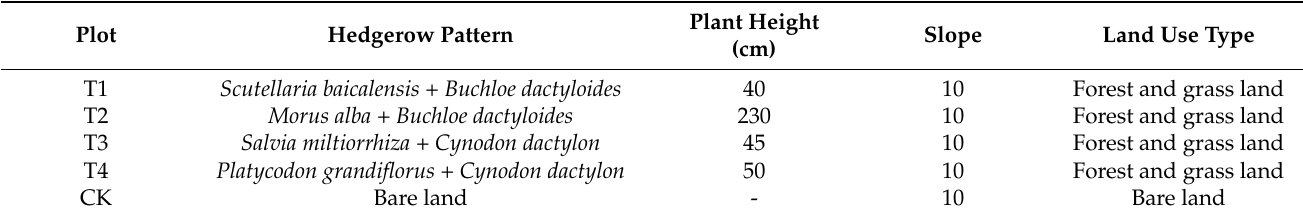
Table 4. Hedgerow patterns in different runoff